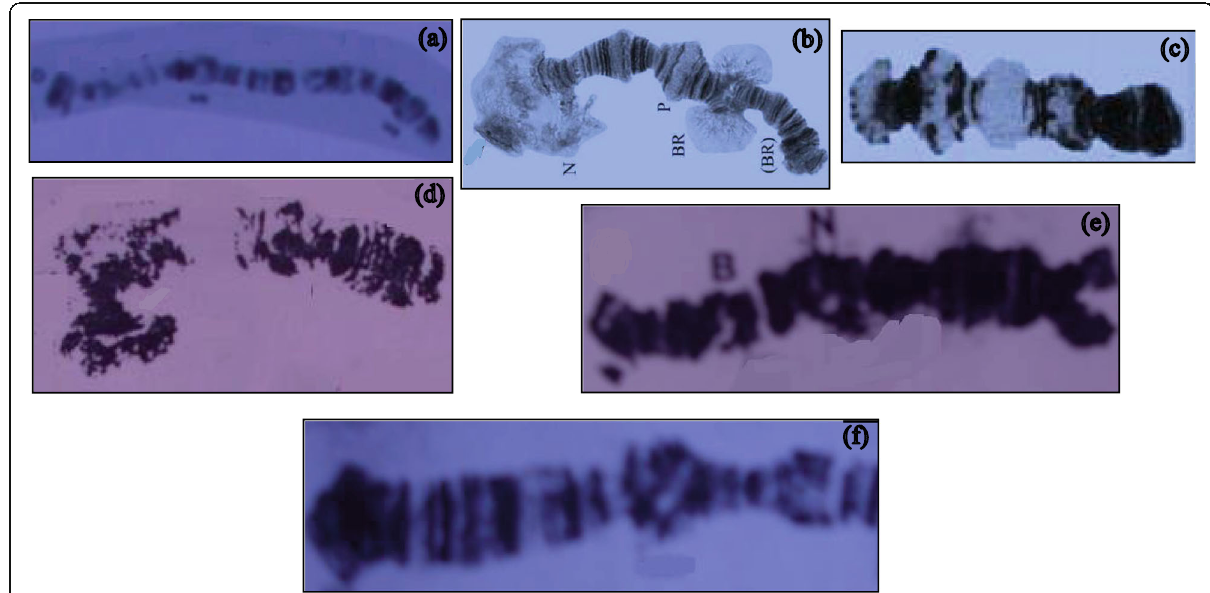
Fig. 8 Arm G of the polytene chromosomes of six species of Chironomus. a C. javanus. b C. dorsalis. c C. riparius. d C. matures. e C. maddeni. f C.